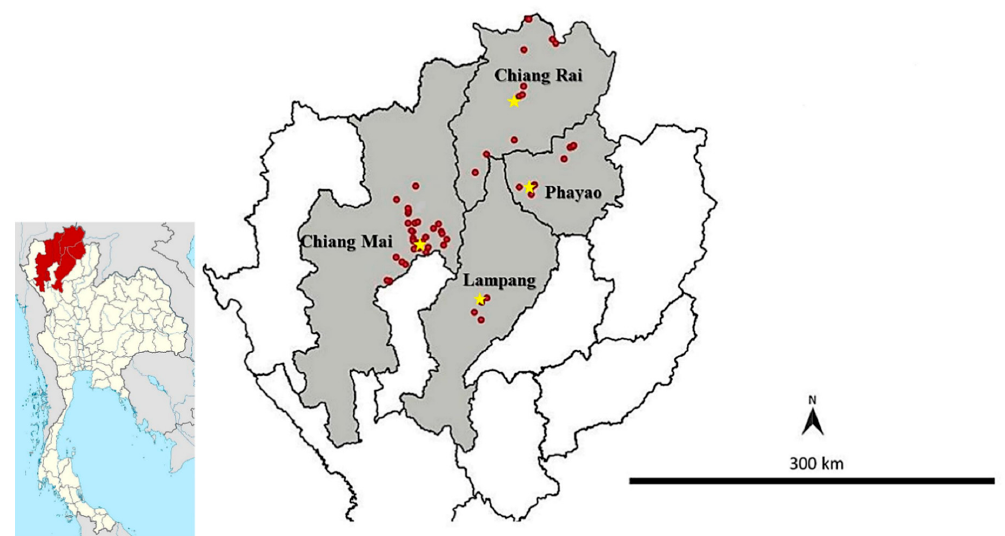
Figure 1. Map of the study areas in Thailand. The gray color indicates four study provinces, red dots indicate the location of sampling sites (temples), and stars indicate the capital city of each province.